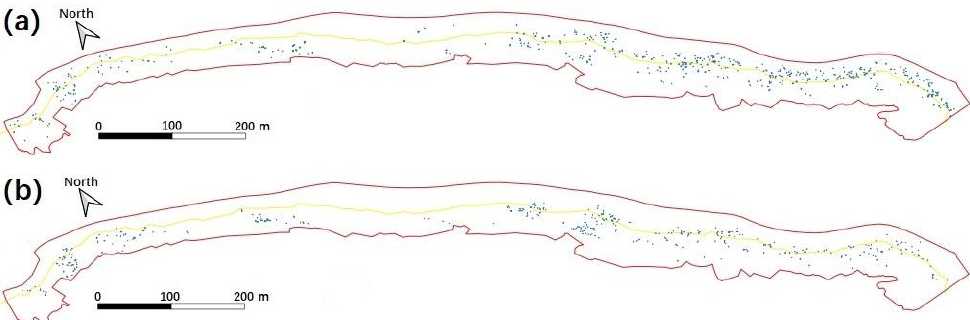
Figure 15. The distribution of volume-computable boulders, where ( a ) shows the comparison of 2017 – 2018, and ( b ) shows the comparison of 2018 – 2019. The red boundary represents the study area, the blue boundaries represent the boulders, and the yellow line represents the boundary between the intertidal and supratidal zones.